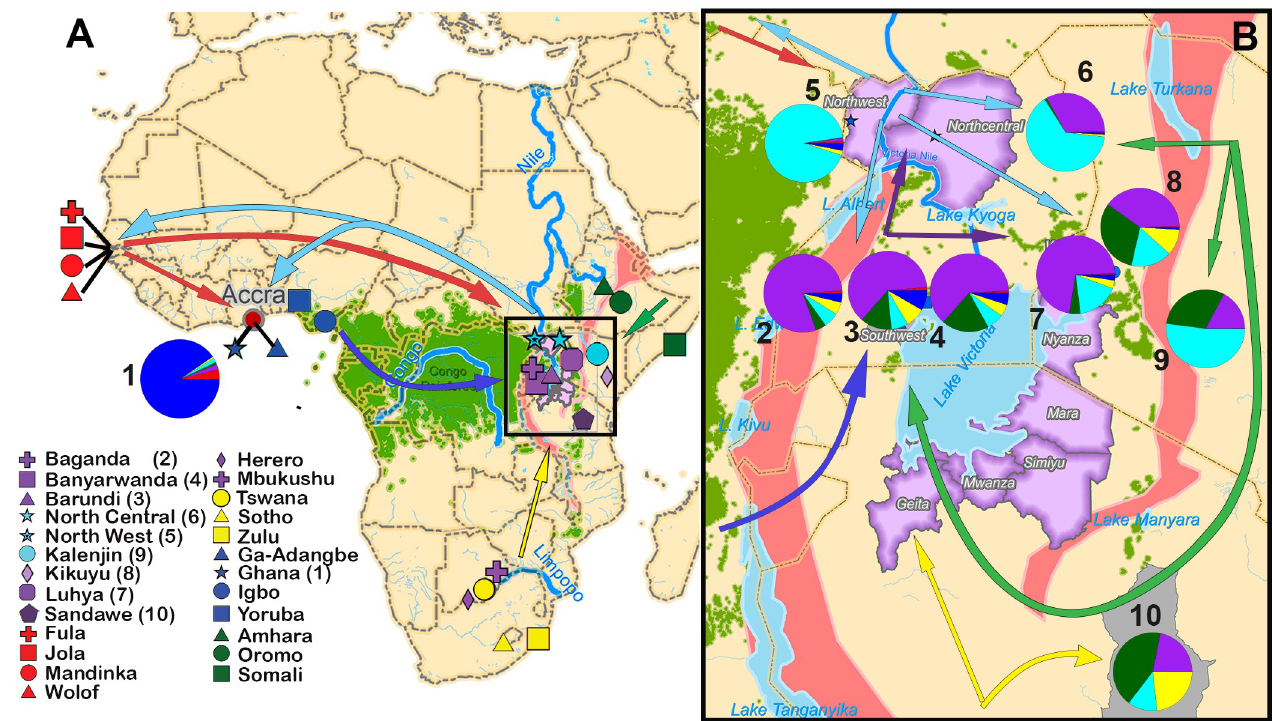
Fig 2. Populations movement routes in relation to major geographical barriers based on genetic inferences. (A) Map of Africa showing the geographical origin of the 22 previously reported Pan-African populations used herein, plus the three new populations from Ghana and the Uganda EMBLEM study (S1 Table). The arrows in the map indicate population gene flow based on significant f3 statistic tests (S2 Table). Colors of the arrows and the pie charts represent the ancestries inferred by ADMIXTURE (Fig 1C). Rather than shortest geographical distance, shapes of the arrows consider the major geographical barriers such as the Congo rainforest (light green), the East and West African Rift valley systems (pink), and the corresponding Rift Valley lakes and rivers (light blue). (B) The zoomed-out map shows the postulated dispersal routes in greater detail, as well as locations of the populations in the East African Rift Valley plateau sampled in previous studies (2 = Barundi, 3 = Banyarwanda, 4 = Baganda in Uganda; 7 = Luhya, 8 = Kalenjin, and 9 = Kikuyu in Kenya; and 10 = Sandawe in Tanzania), and the Uganda EMBLEM study populations [5 = Uganda North West (UNW), 6 = Uganda North Central